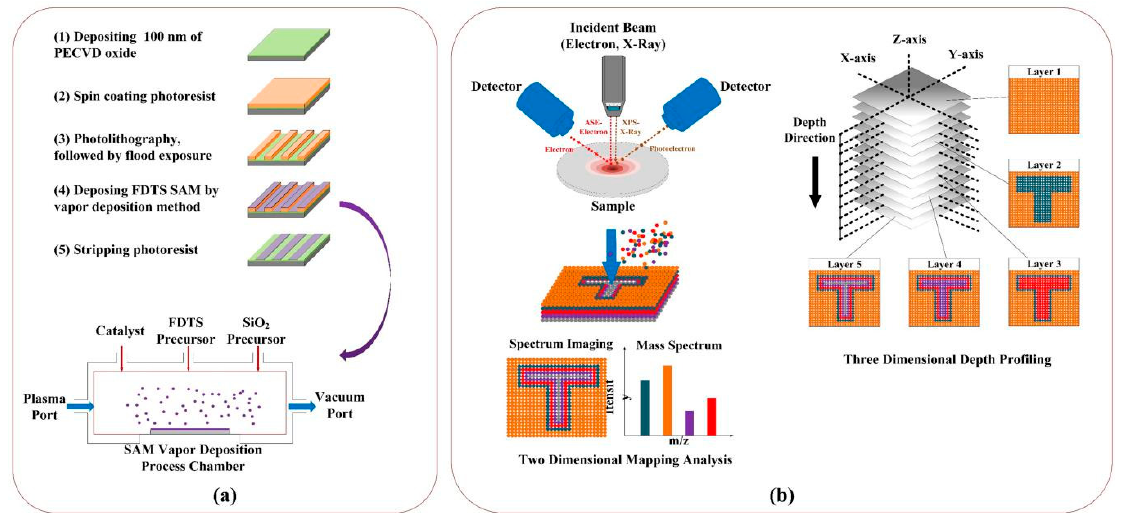
Figure 1. Schematic diagram of microfabrication and characterization of FDTS SAM film patterns based on SAM vapor deposition technique. ( a ) Fabrication process by several semiconductor fabrication techniques combined, including photolithography, SAM vapor deposition, and lift-off technique; ( b ) characterization process by AES and XPS.